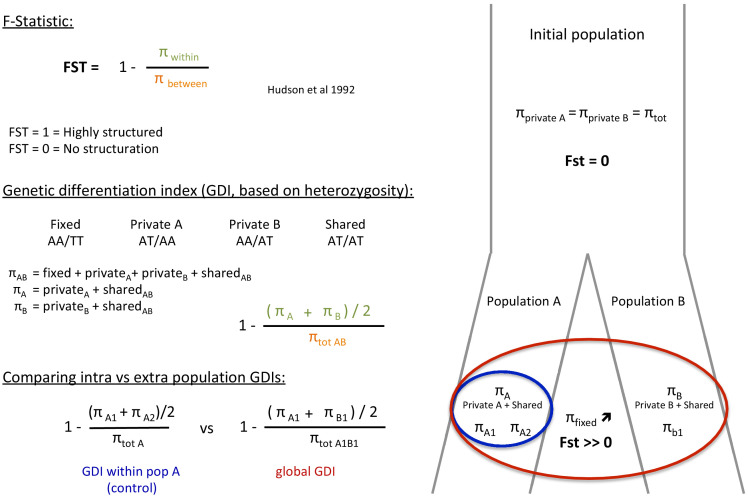
Definition of the genetic differentiation index (GDI) based on the F-statistic (FST).The main difference between these two indexes is the use of heterozygous allele states for GDI rather than real polymorphism for the FST. Green = πwithin, Orange = πbetween, Blue = Population A, Red = Population A+B.